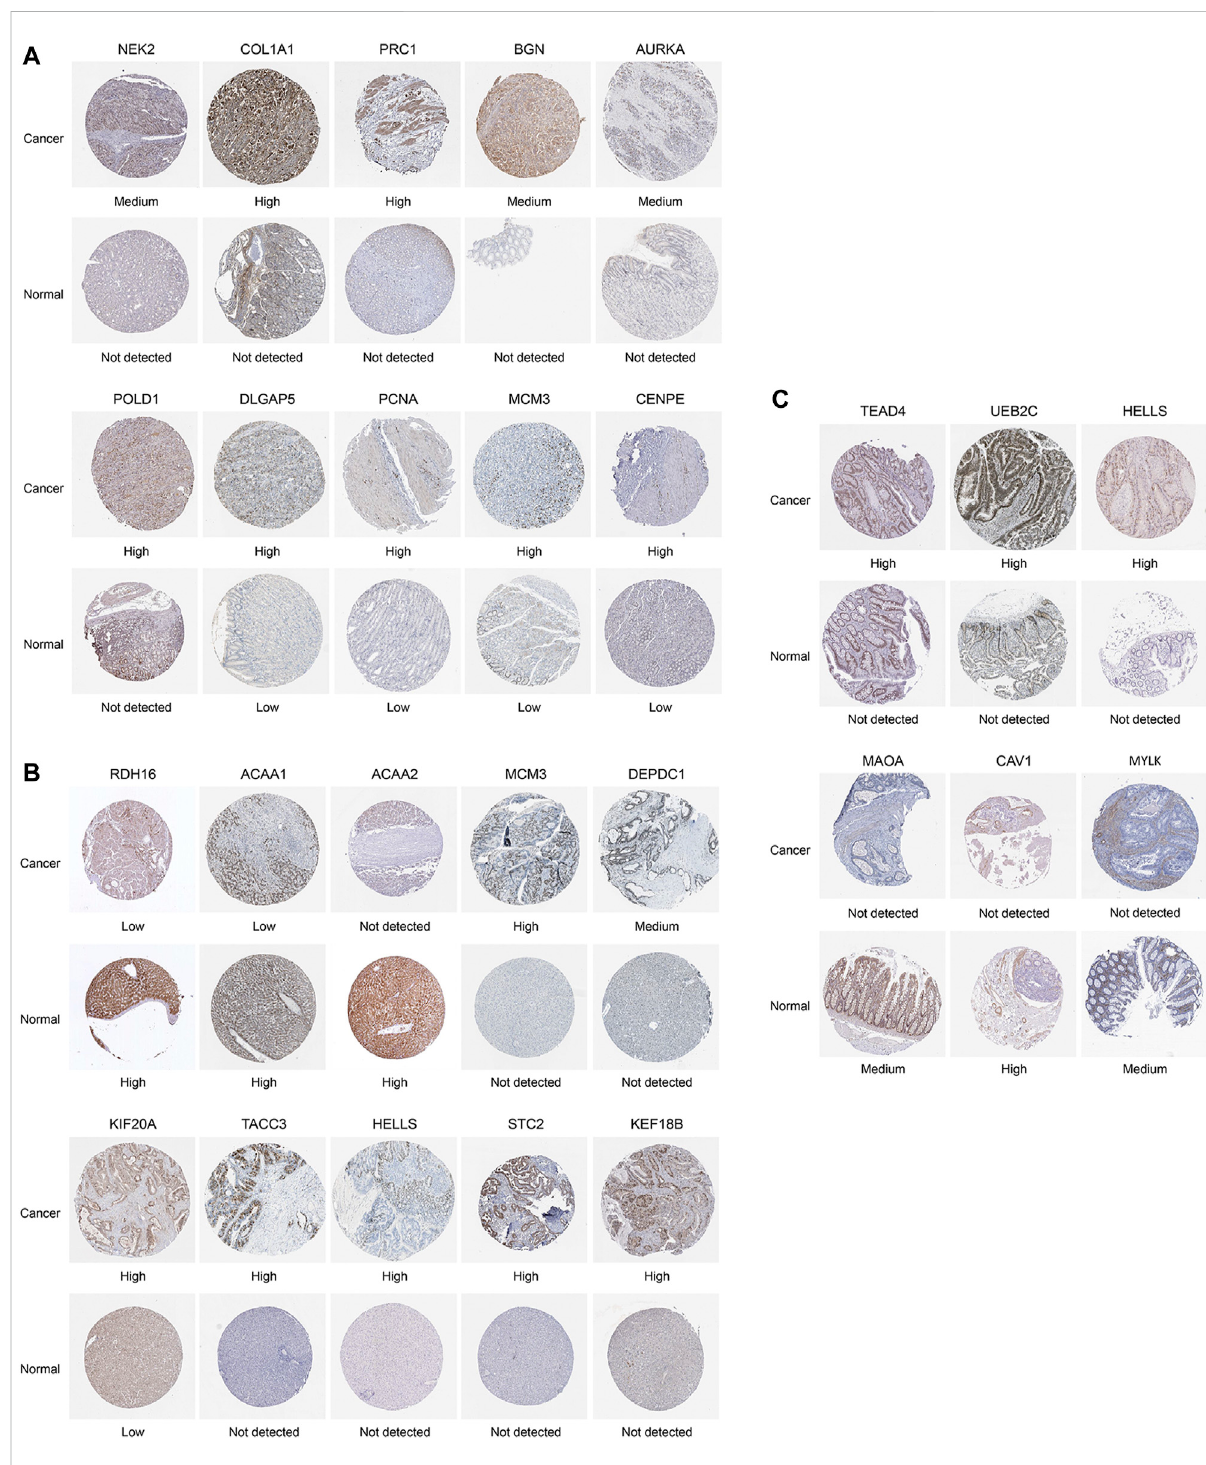
FIGURE 9 Images for part of fi nal leader gene immunohistostaining between cancer tissues and normal tissues in the Human Protein Atlas database. (A) Stomach cancer. (B) Liver cancer. (C) Colon cancer. High, medium, low, or not detected represent the expressional levels of the gene products, whose difference meant expression difference for gene